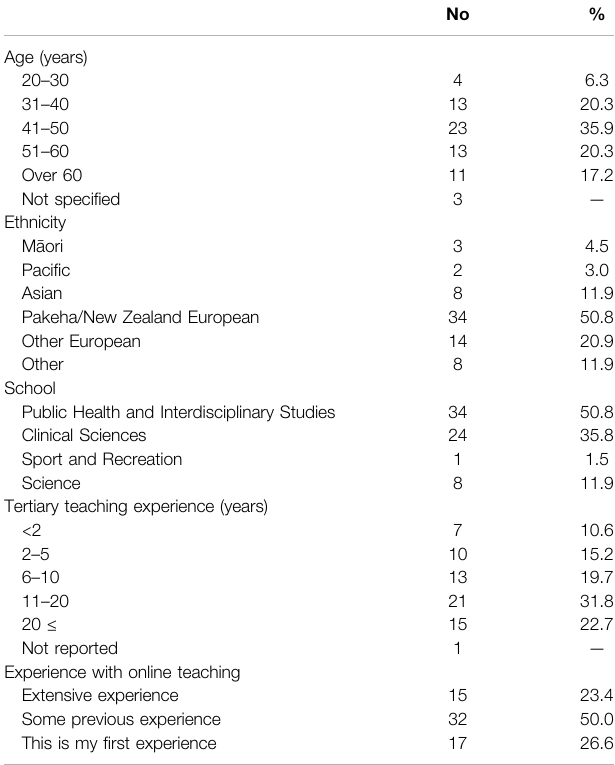
TABLE 1 | Participant demographics ( n (cid:1)